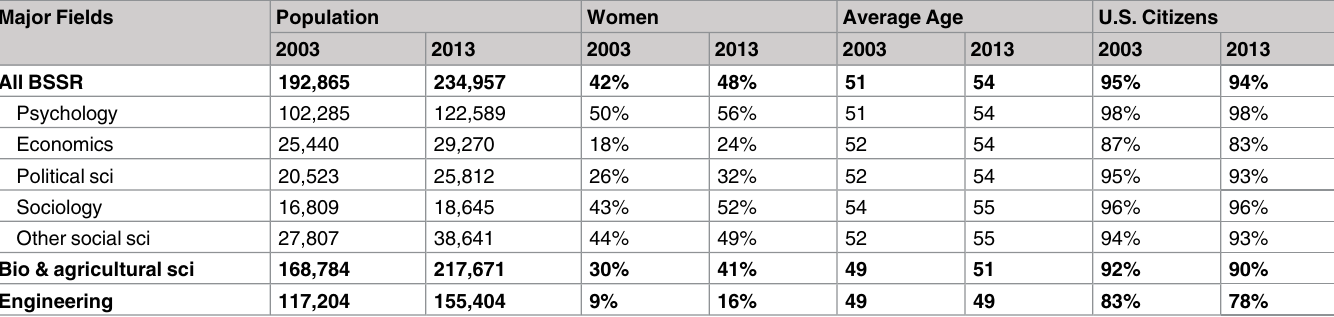
Table 1. Demographic trends in the BSSR workforce by gender, age, and citizenship.